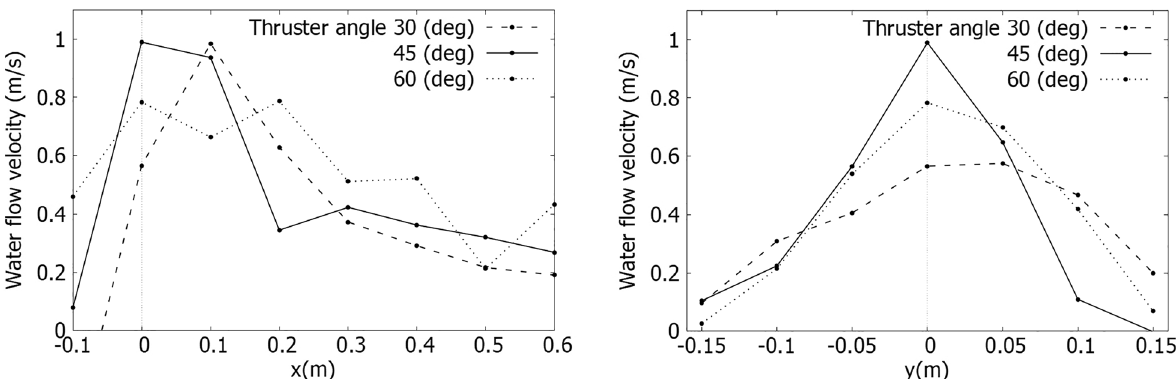
Fig. 5 Experiment results found for the water flow speed. The left panel shows the water flow speed along the x-axis. The right panel shows that along the